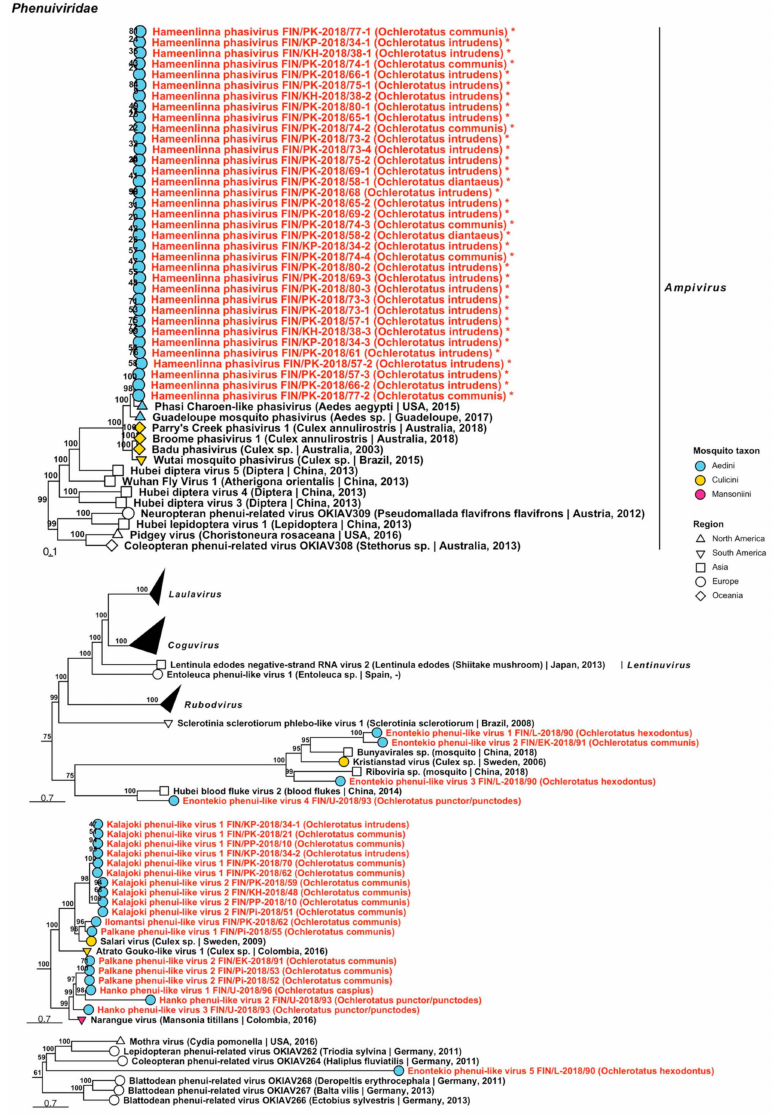
Figure 12. Maximum likelihood subtrees of Phenuiviridae . Tentative novel viruses are displayed in red and the mosquito species from which they were derived are in parentheses. Sequences from GenBank are black and display the following information after the virus or species name: “(sampled organ- ism(s)|collection country, collection year)”. Tip colours represent the tribe of mosquito from which viruses were obtained. Tip shape represents the continent or region from which the specimens were collected. Trees were constructed from amino acid sequences of virus polymerases >1000 nt, aligned with MAFFT and computed with IQ-TREE2 using ModelFinder and 1000 bootstraps. Asterisks denote that the complete genome was